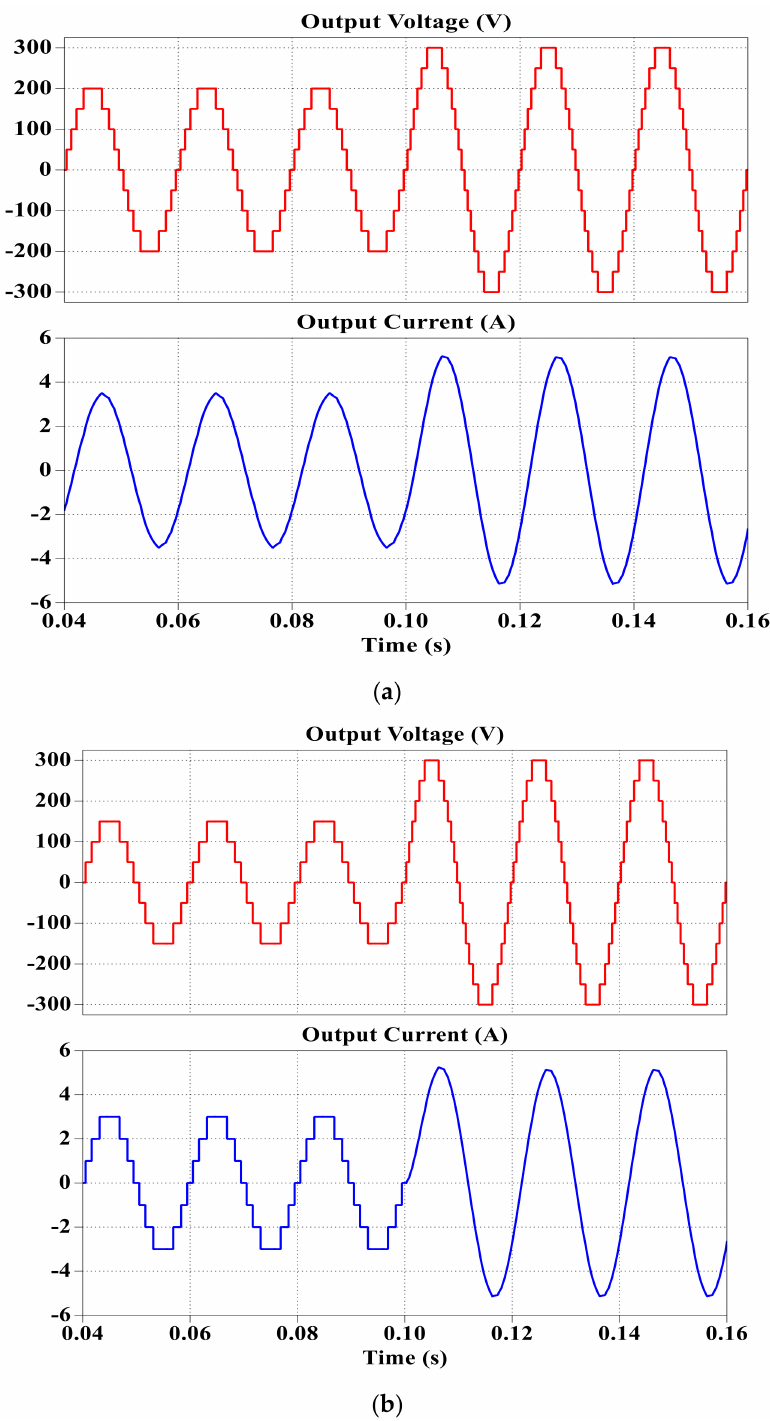
Figure 8. Terminal voltage and Load current for ( a ) change of MI with R-L load and ( b ) change of MI and load from R load to R-L